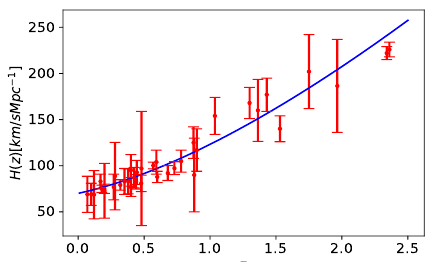
Figure 15. Hubble data as a function of redshift z for Cosmic Chronometers. The solid line corre- sponds to the best-fit by using Λ CDM